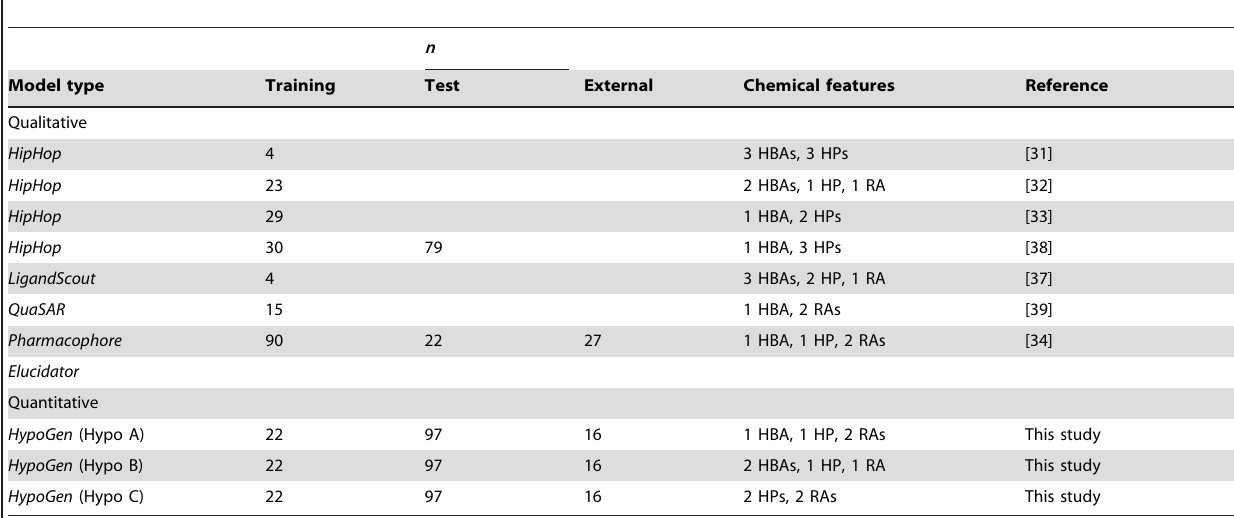
Table 6. Summary of developed BCRP inhibition qualitative and quantitative pharmacophore